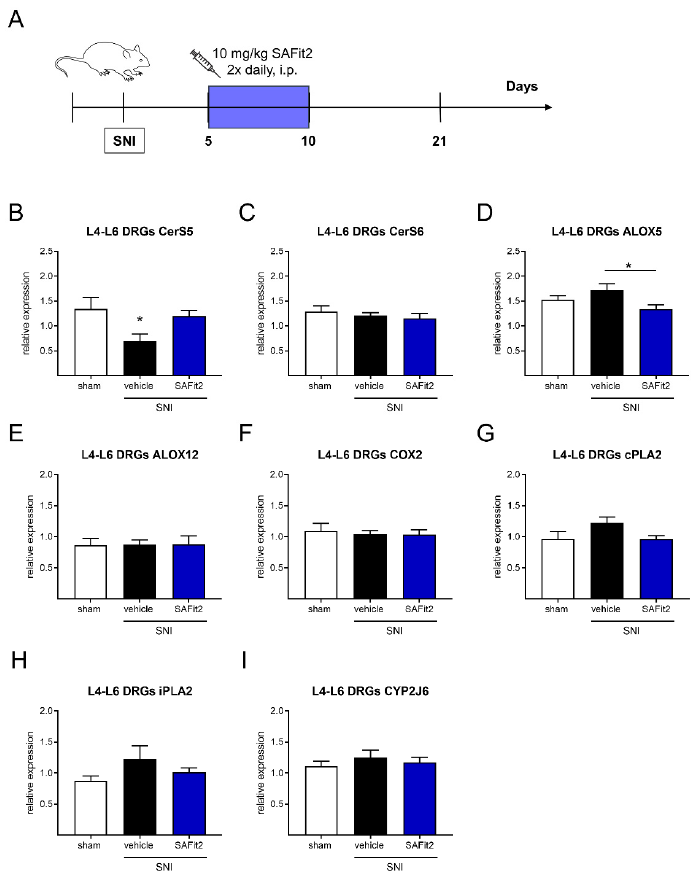
Figure 1. Gene expression of ceramide synthases, lipoxygenases, phospholipases, and epoxygenases in lumbar DRGs of nerve-injured mice after additional SAFit2 treatment. ( A ) Schematic illustration of the experimental procedure: SNI surgery was performed followed by a treatment with either 10 mg/kg SAFit2 or vehicle on six consecutive days (days five to ten) after SNI. The gene expression of ceramide synthases ( B , C ), lipoxygenases ( D – F ), phospholipases ( G , H ), and epoxygenase ( I ) was measured 21 days after the surgery. The data are displayed as the mean ± SEM of technical replicates from three to four mice per treatment. * p < 0.05, as per one-way ANOVA with Tukey´s post-hoc test. Abbreviations: DRGs: dorsal root ganglia; SAFit2: selective antagonist of FKBP51 by induced